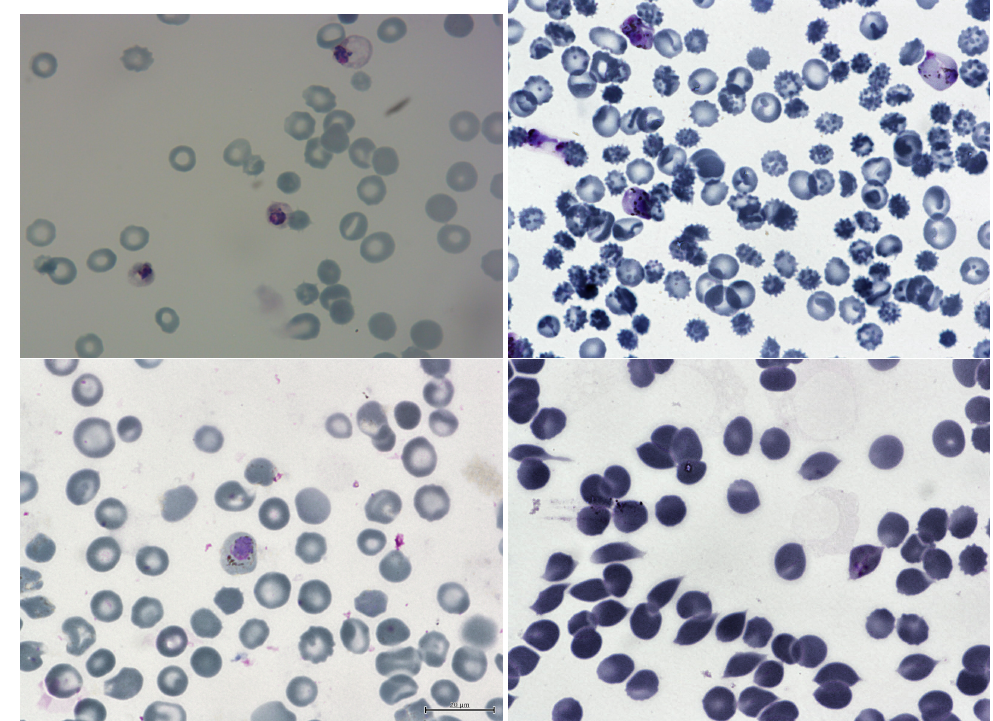
Figure 2. This sample dataset consists of blood smear samples that have been analyzed under a microscope. The samples contain a mixture of uninfected and malaria-infected red blood cells (RBCs). The uninfected RBCs are visible as monochromatic oval shapes with a light center and smooth surface. They have a normal appearance and do not exhibit any signs of infection. On the other hand, the RBCs that are infected with malaria appear rather different. They are shape-distorted and have a pinkish-purple color due to the presence of the malaria parasites within them. These parasites can take various forms, such as single rings or multiple eosinophilic dots, which can be seen inside the RBCs. The infected RBCs are generally larger and more irregular in shape compared to the uninfected RBCs. In addition to the RBCs, the blood smear samples may also contain singular white blood cells (WBCs). These cells are part of the body’s immune system and help to defend against infections. The WBCs in these samples are generally bigger in size and have a smooth shape with eosinophilic nuclei. They may be present in higher numbers due to the body’s immune response to the malaria